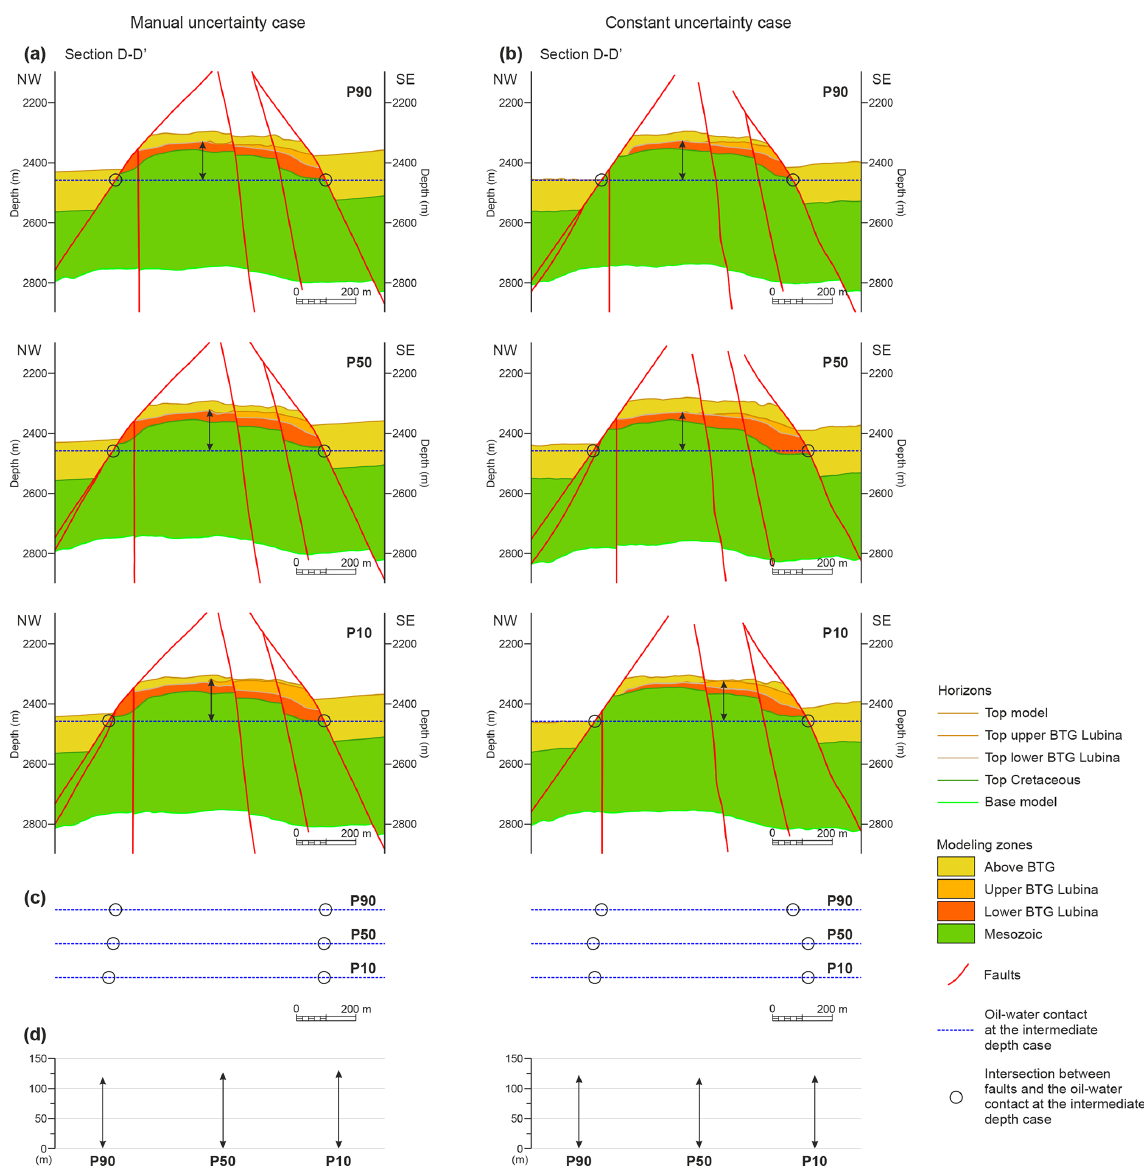
Figure 15. Cross section D–D’ of the structural model in the northern sector of the Lubina culmination for the intermediate oil–water contact depth case showing the realizations corresponding to the proved (P90), probable (P50) and possible (P10) scenarios of the manual (a) and the constant (b) uncertainty cases. (c) Diagrams showing the position of the intersection between the major faults bounding the reservoir laterally and the oil–water contact for the P90, P50 and P10 scenarios. (d) Diagrams showing the maximum vertical distance between the reservoir top and the oil–water contact for the P90, P50 and P10 scenarios. Vertical exaggeration is 2 × . See the position of the section in Fig.